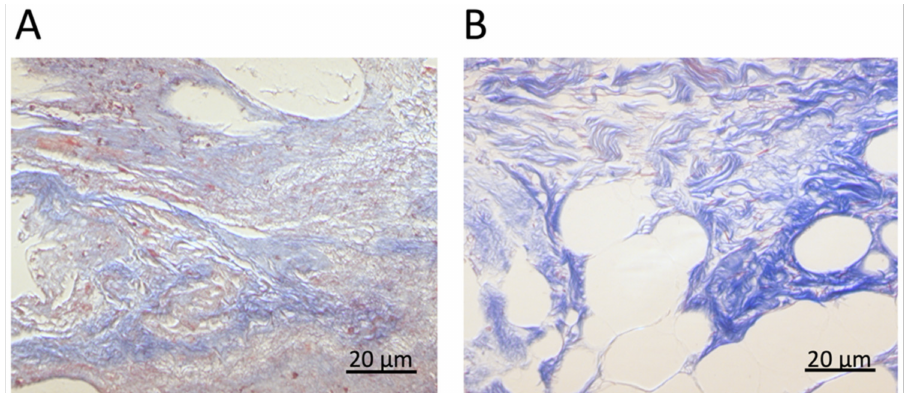
Figure 5. Collagen of ECM of healthy ( A ) and tumoral region ( B ) stained with van Gieson trichrome.